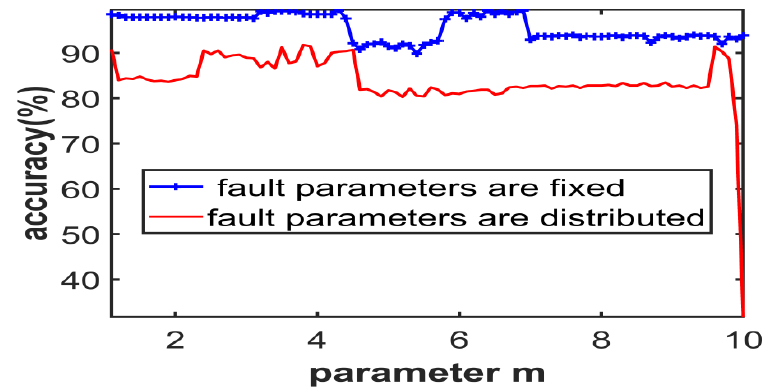
Figure 6. The curve of the influence of parameter m on accuracy under two kinds of fault parame- ters.